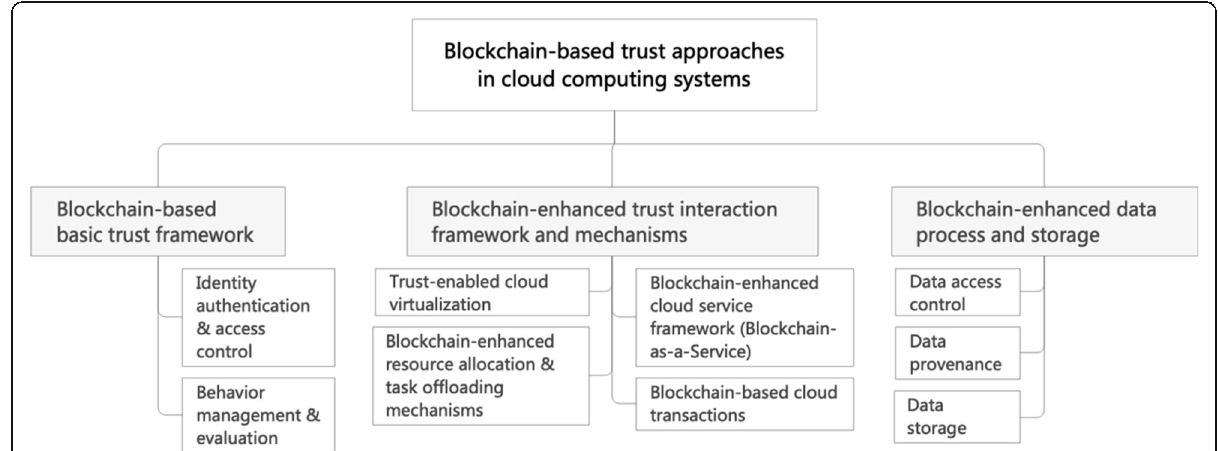
Fig. 2 Phases of blockchain-based trust approaches in cloud computing